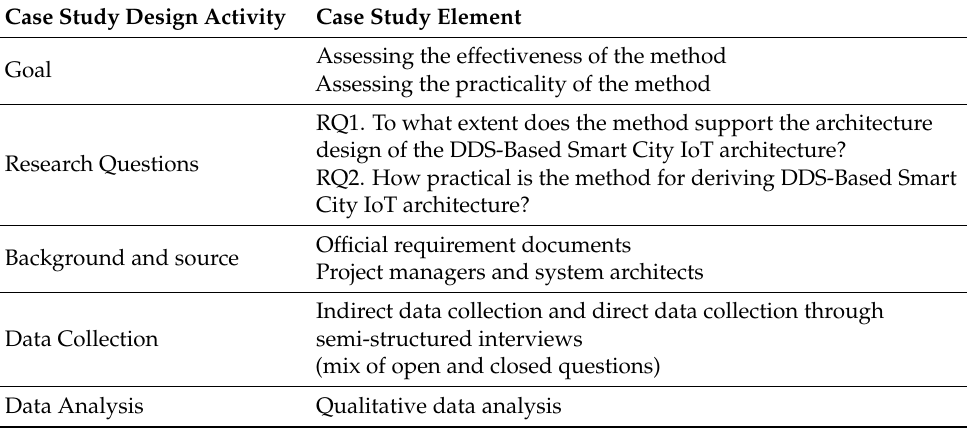
Table 1. Case Study